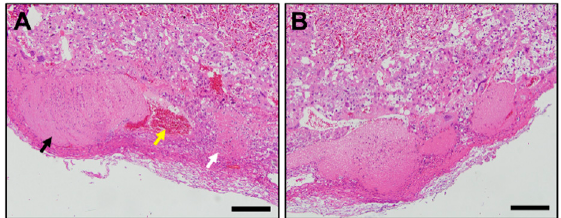
Figure 7. Histological analysis of the decidua of Stab1 / 2 dKO placenta. ( A , B ) High-magnification images of the black rectangles in the placenta from Stab1 / 2 dKO mouse shown in Figure 5A. In ( A ), black, yellow, and white arrows indicate decidual hemorrhage, maternal artery, and decidual necrosis with fibrin deposition, respectively. Scale bar, 200 µm.